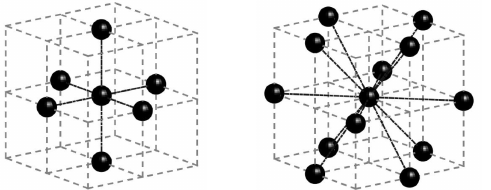
Figure 13. Two possible stencils: standard 7-point ( left ) and cubic close-packed (CCP) 13-point ( right ). Image credit: see reference